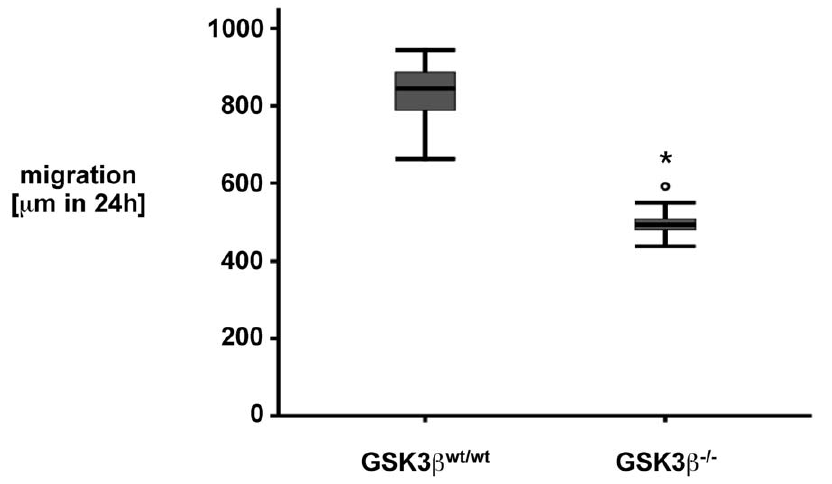
Figure 6. GSK3ß 2 / 2 mouse embryonic fibroblasts display reduced restitution in response to scrape-wounding as compared to GSK3ß wt/wt cells. Mouse embryonic fibroblasts (MEF) were prepared from GSK3ß 2 / 2 and GSK3ß wt/wt mice and grown to confluency. Cells were serum-starved overnight, standardized wounds were created using a razor blade and restitution was monitored over 24 h using serial microphotography. Data are expressed as median and interquartile range (IQR) of n=9 independent wounds per condition. Statistical analysis was performed by the Kruskal-Wallis test for non-parametric data (*p , 0.05 versus control).